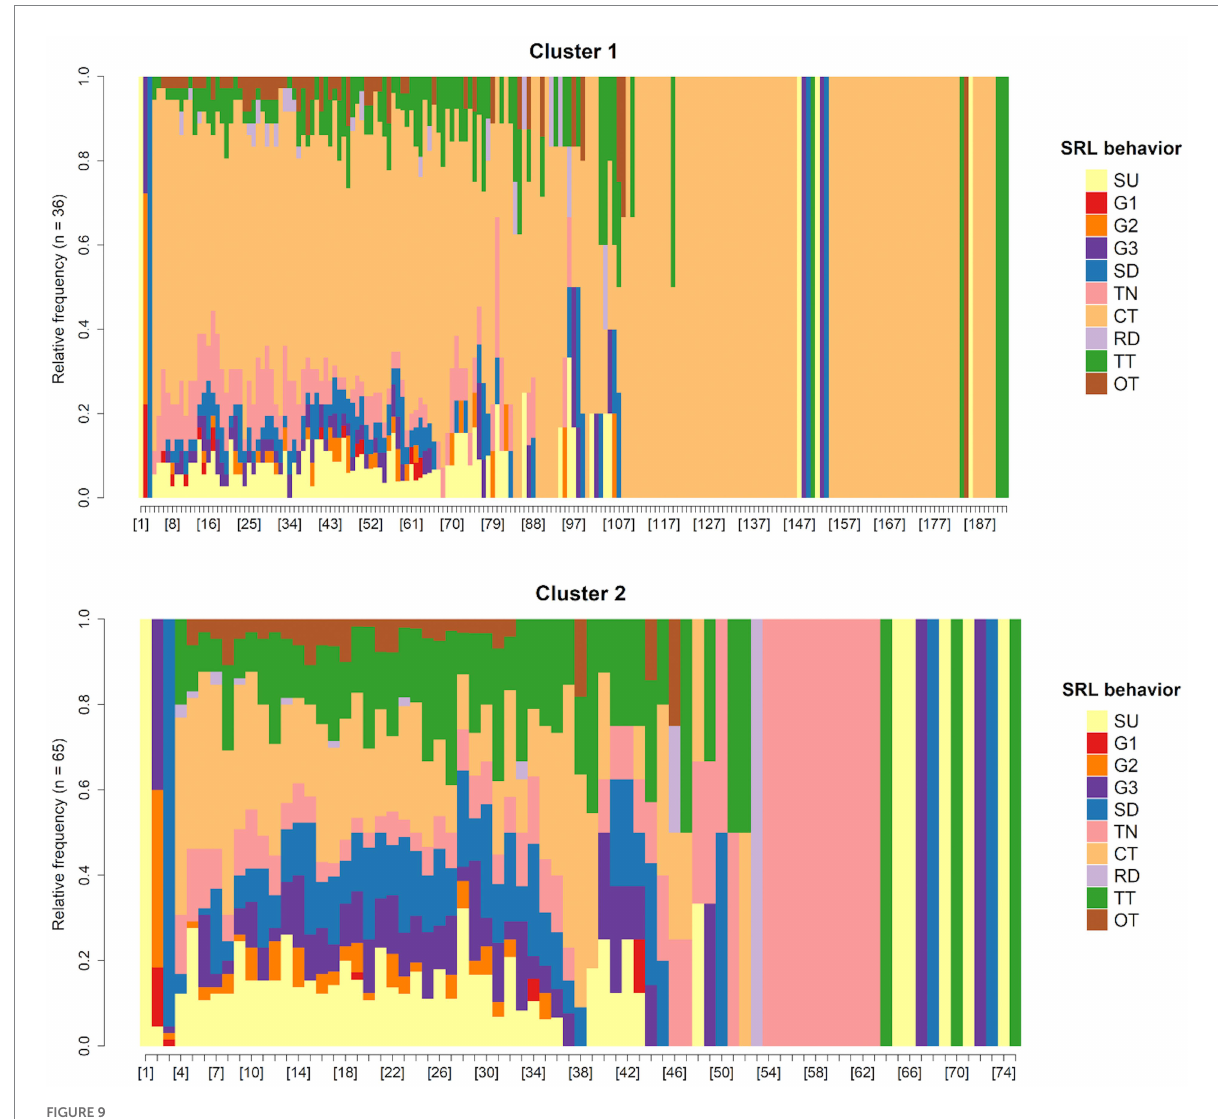
FIGURE 9 SRL behavior distribution plots by